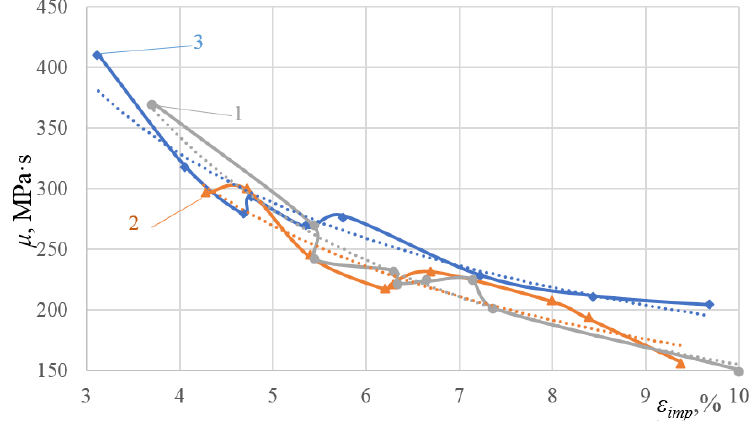
Figure 11. Experimental effective shear viscosity μ versus ε imp dependences for aluminum alloys: 1 — alloy 2024-T351; 2 — alloy D16ChATW; 3 — alloy T.